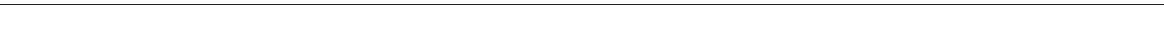
Fig. 3 Differentially expressed genes show length-dependent misregulation in topotecan datasets but not in MeCP2 studies. a Scatter plot of log fold change in expression between topotecan and vehicle-treated cultured cortical neurons ( y -axis) against its gene length ( x -axis) in RNA-seq data from King et al. 10 (left panel; n = 5 each; FDR < 0.05) and Mabb et al. 19 (right panel; n = 3 each; FDR < 0.01). b Scatter plot of log fold change in expression (microarray) between C57BL KO and its C57BL WT littermates ( y -axis) against its gene length ( x -axis) in hypothalamus 22 (left panel; n = 4 each; FDR < 0.05 and log 2 FC > 0.2) and cerebellum 21 (right panel; n = 4 each; FDR < 0.05 and log 2 FC > 0.2). c Scatter plot of log fold change in expression (microarray) between FVB Tg to its FVB WT littermates ( y -axis) against gene length ( x -axis) in hypothalamus 22 ( n = 4 each; FDR < 0.05 and log 2 FC > 0.2) and cerebellum 21 ( n = 4 each; FDR < 0.05 and log 2 FC > 0.2). d Scatter plot of log fold change in expression between KO or Tg and WT littermates ( y -axis) against gene length ( x -axis) in RNA-seq datasets: Hypothalamus KO/WT comparison 23 (left panel; n = 3 each; FDR < 1e − 5) and hypothalamus Tg/WT comparison 23 (right panel; n = 3 each; FDR < 1e − 5). Red dots indicate long genes and blue dots indicate short genes. Differentially expressed genes were obtained from the published gene lists. See Supplementary Fig. 5 for additional analyses from published MeCP2